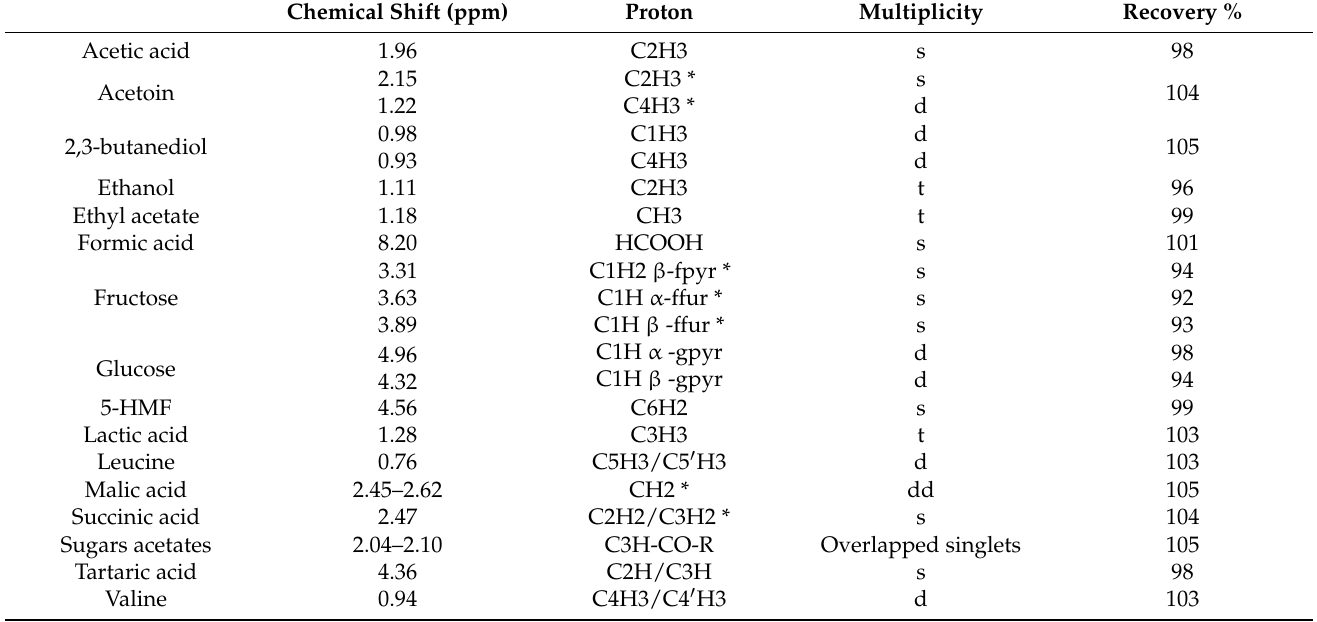
Table 1. Signals used for the quantification of principal compounds in BVMs and TBVs and recovery